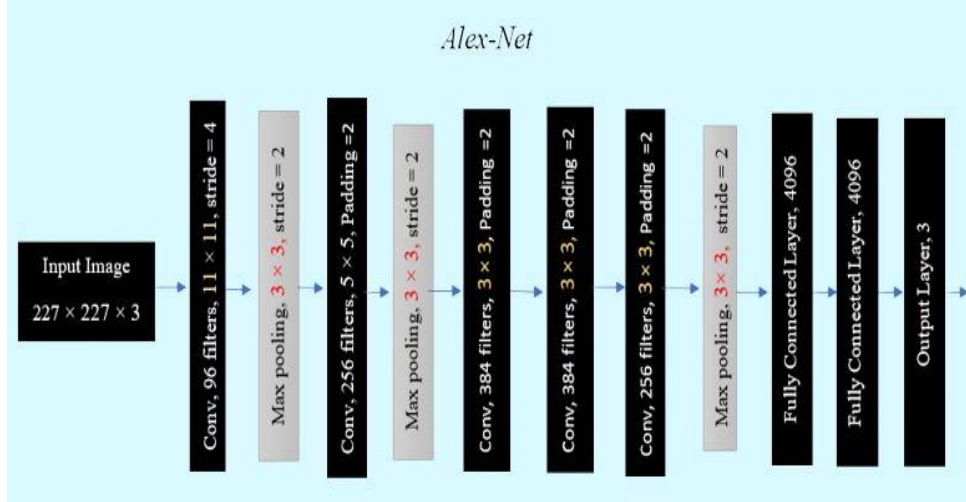
Figure 5. The architecture of the AlexNet model.